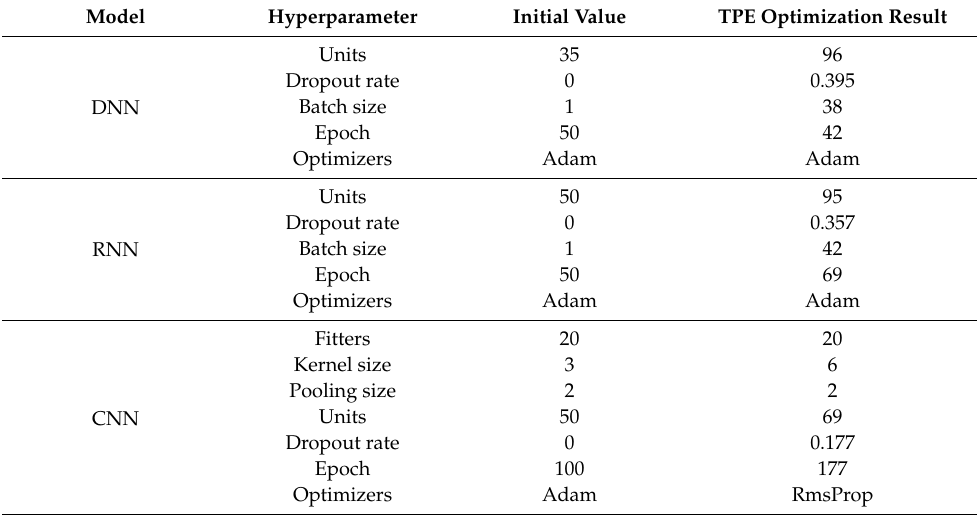
Table 4. The TPE optimization result of hyperparameters in the DNN, CNN, and RNN